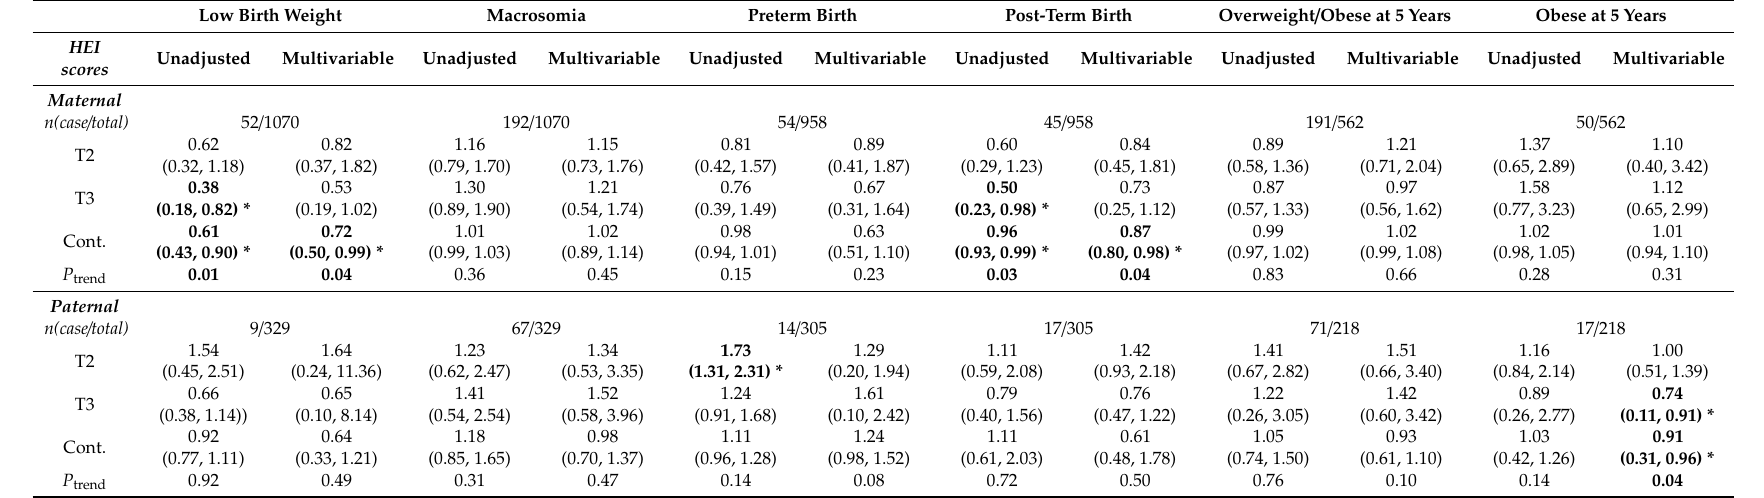
Table 3. Associations between parental HEI scores and binary o ff spring outcomes at birth and at five years 1 . Low Birth Weight Macrosomia Preterm Birth Post-Term Birth Overweight / Obese at 5 Years Obese at 5 Years Multivariable Unadjusted Multivariable Unadjusted Multivariable Unadjusted Multivariable Unadjusted Multivariable Unadjusted